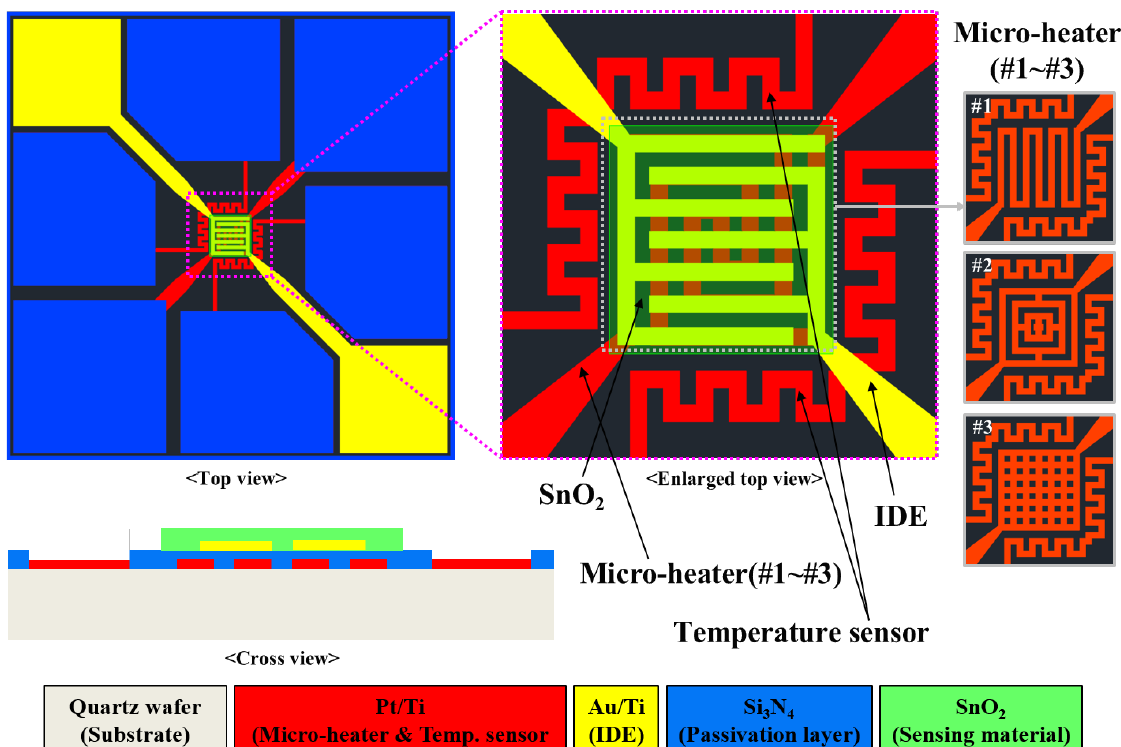
Figure 2. Schematic of the proposed SnO 2 -based H 2 S microsensor with three types of micro-heaters. The micro-heater types #1–#3 had patterns of meander, rectangular, and rectangular mesh, respectively. The proposed SnO 2 -based H 2 S microsensor comprised micro-heaters (types #1–#3), a temperature sensor, an IDE, and a sensing material (SnO 2 ). The sensor and sensing area measured 3 mm × 3 mm and 100 µ m × 100 µ m, respectively. The width and thickness of a micro-heater, temperature sensor, and IDE were 20 µ m and 200 nm, respectively. To minimize the loss of thermal energy produced by